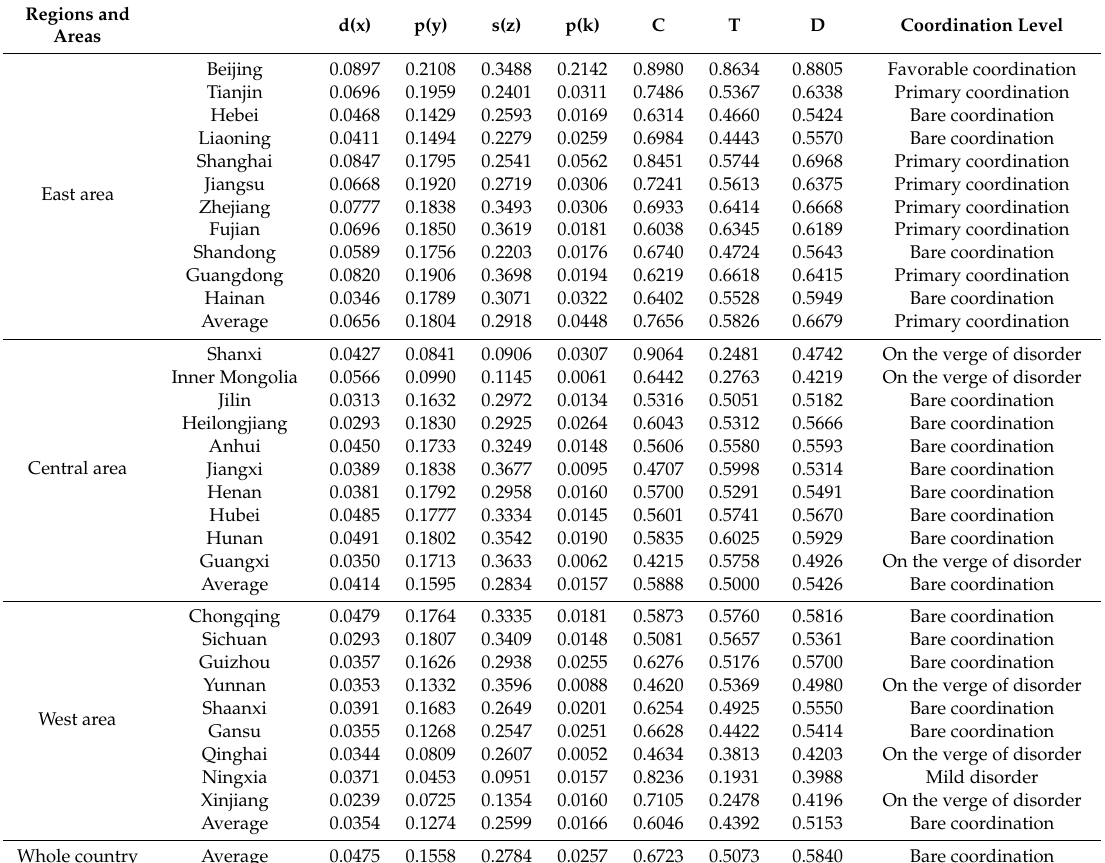
Table 9. The regional comparisons in